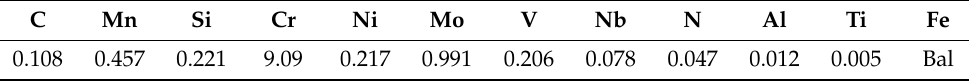
Table 1. Chemical composition of the P91 steel